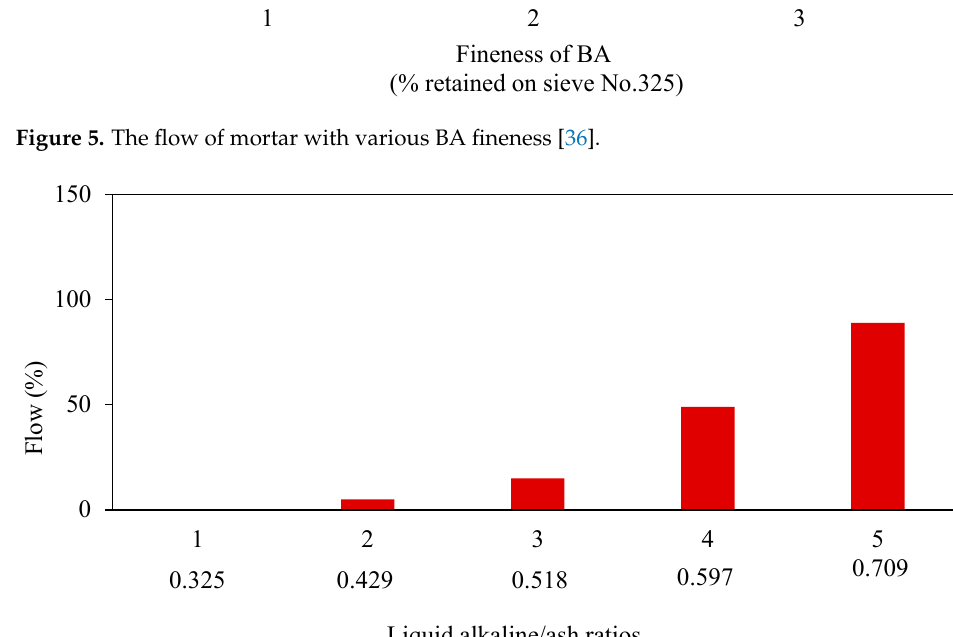
Figure 6. The flow of mortar with various liquid alkaline-to-ash ratios [36]. Bhowmick and Ghosh [39] determine the impact of fly ash/sand ratios and the influ- ence of SiO 2 /Na 2 O ratio inactivators on GPM workability. They found that the flow value percentage increases with the fly ash/sand ratio, and the fresh geopolymer mortar’s flow- ability increases as the SiO 2 /Na 2 O ratio in the activator increases, as shown in Figures 7 and 8.